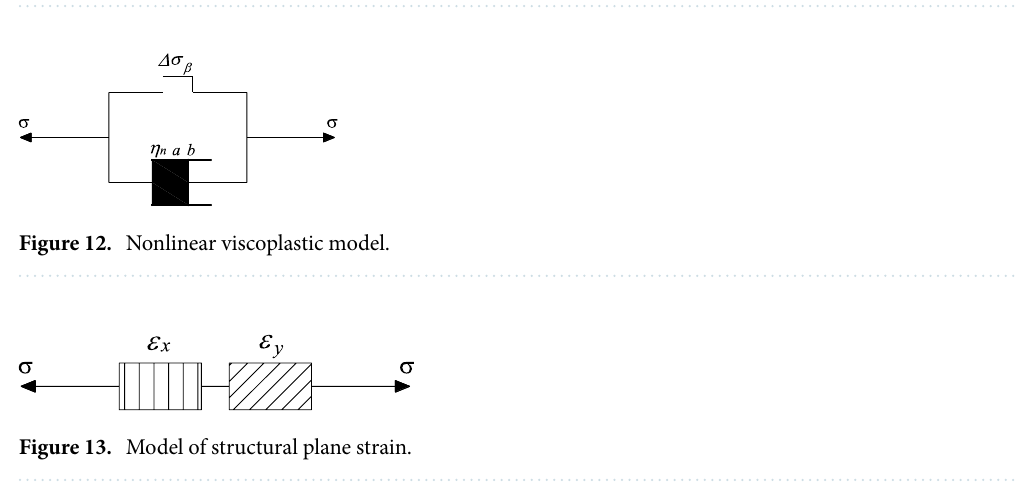
Figure 11. Nonlinear rheological curves for different values of parameter b.